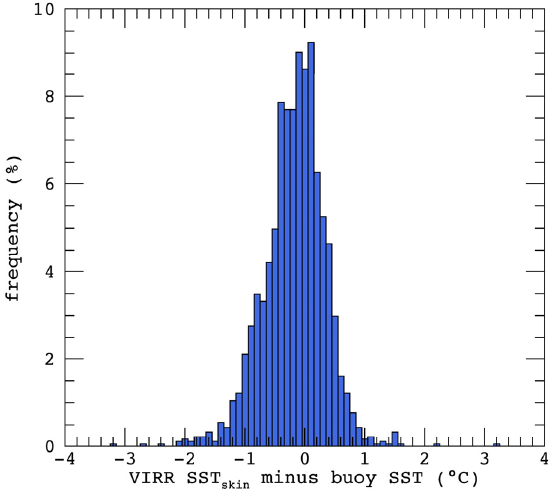
Figure 11. Histogram of bias of VIRR SST skin and buoy SST.